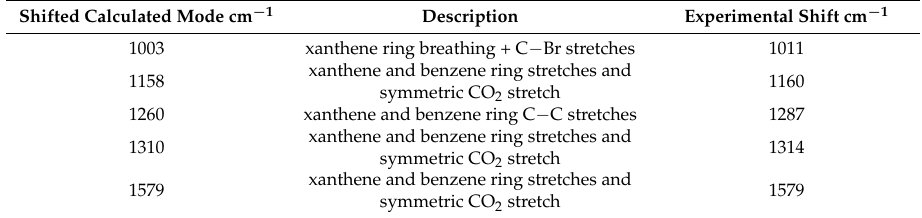
Table 1. Calculated and experimental Raman scattering modes of Eosin Y at 785 nm excitation [77].